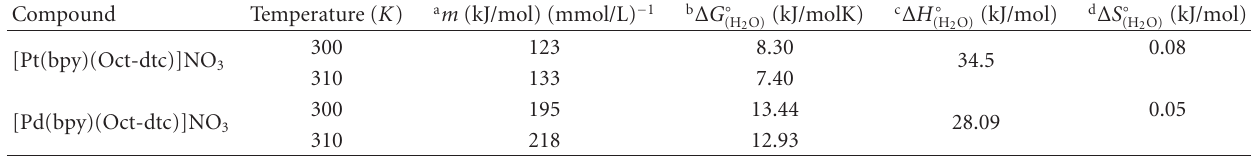
a Measure of the metal complex ability to denature CT-DNA. b Conformational stability of CT-DNA in the absence of metal complex. c The heat needed for CT-DNA denaturation in the absence of metal complex. d The entropy of CT-DNA denaturation by metal complex.